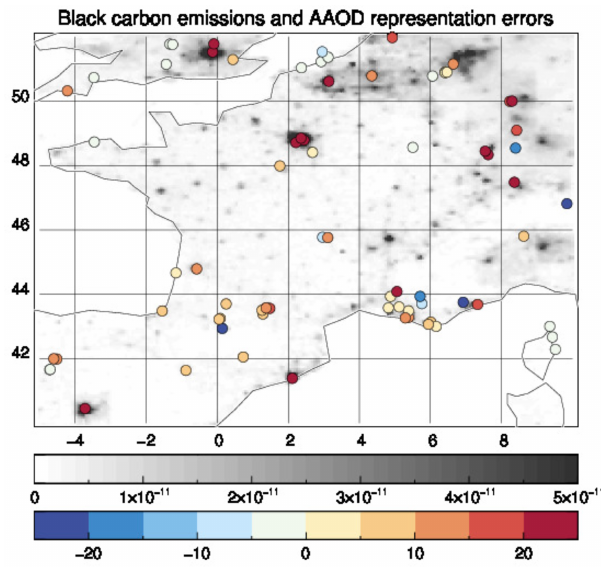
Figure 13. Black carbon emissions over France (Europe) with the representation errors in AAOT from AERONET inversion L1.5 su- perimposed. The top colour bar (white–black) represents emissions (kgm − 2 s − 1 ), and the bottom colour bar (blue–red) represents rela- tive representation errors (%). Only spatial representation errors are shown; i.e. the temporal sampling of observations is